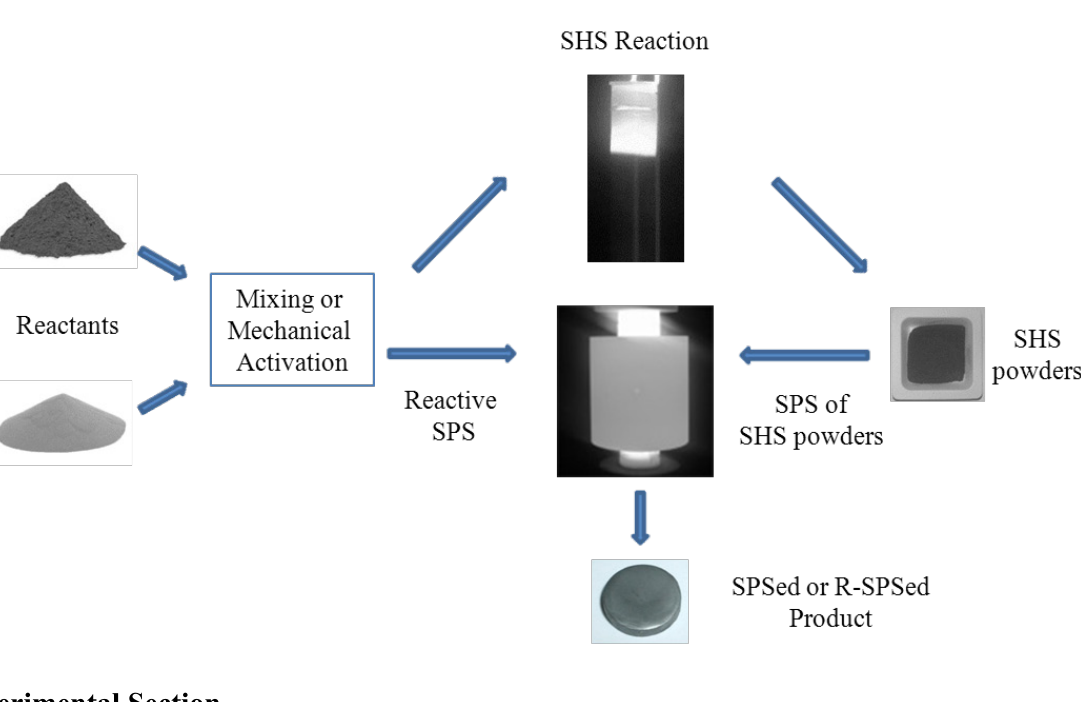
Figure 1. Spark Plasma Sintering routes adopted in this work for the fabrication of bulk ultra high temperature ceramics